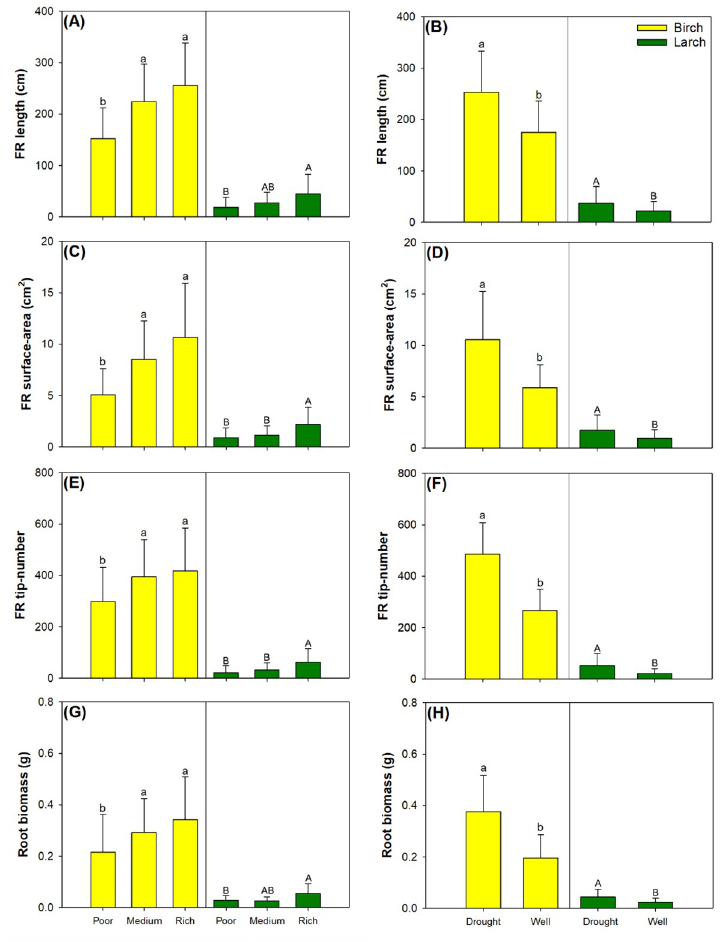
Fig 4. Fine root length (A, B), surface-area (C, D), tip-number (E, F), and biomass (G, H) in birch ( Betula Platyphylla ) and larch ( Larix olgensis ) seedlings subjected to heterogeneous or homogeneous nutrient patterns (left) or in drought vs well-watered conditions (right). Bars indicate standard deviations. Different letters indicate significant difference of raw transformed data (see S1 Table) according to Duncan test at 0.05 level. Lower case letters stand for differences for birch seedlings and capital letters for larch